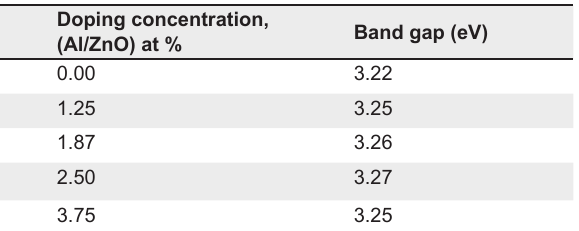
Table 1. Band gap of ZnO : Al films deposit with different Al-content Doping concentration, (Al/ZnO) at